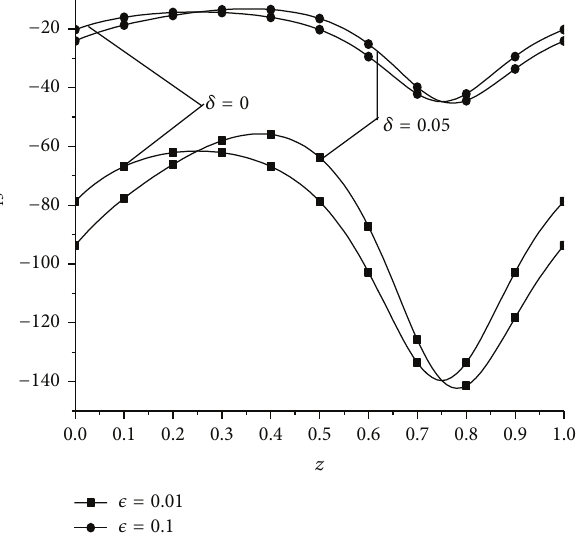
Figure 15: Wall shear stress 𝜏 13 at the inner wall versus 𝑧 with different values of 𝛿 and 𝜖 at Wi = 0.01 , 𝑄 = 1.5 , 𝜙 = 0.4 , and Re = 10